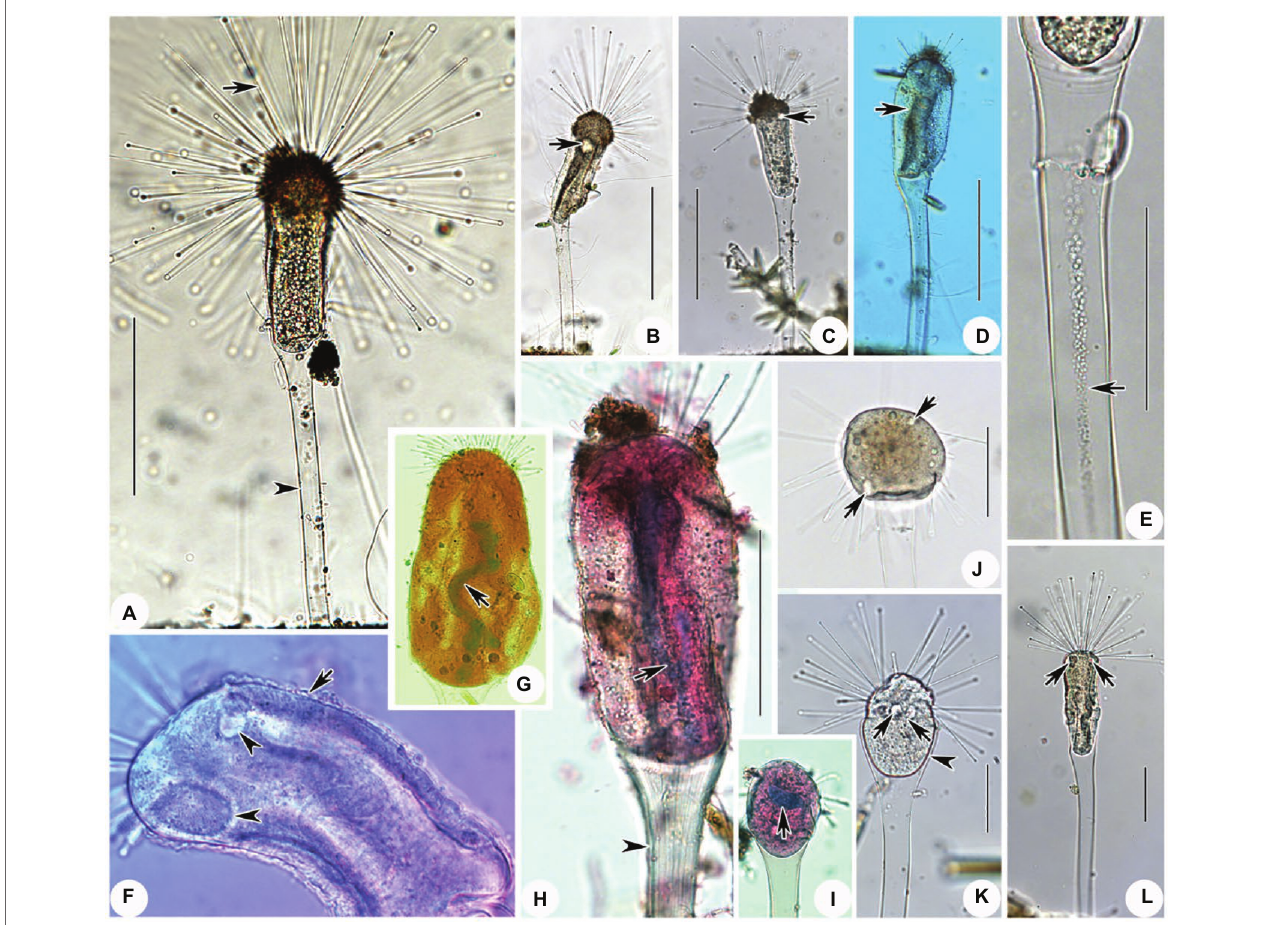
FIGURE 5 | Photomicrographs of Peridiscophrya florea (Kormos & Kormos, 1958) Dovgal, 2002 from life (A–F , J–L) and after Methyl Green-Pyronin Staining (G–I) . (A) Peridiscophrya florea in vivo . Arrow to show tentacle. Arrowhead to show stylotheca. (B–D) Different individuals. Arrows in (B,C) to indicate contractile vacuoles. Arrow in (D) to indicate longitudinal furrows. (E) Same individual as (J–L) enlarged to show the particles (arrow) in stylotheca. (F) Enlarged the ciliate body. Arrow to show lorica with dense rings. Arrowheads to show the contractile vacuoles. (G–I) Peridiscophrya florea after Methyl Green-Pyronin Staining. Arrow in (G) to show the filiform macronucleus. Arrow in (H) indicates ramified macronucleus. Arrowhead to show vertical lines on the stylotheca. Arrow in (I) to show rod-like macronucleus during the growth process. (J–L) The process of lorica growth. Arrows in these pictures to show contractile vacuoles. Arrowhead in (K) to show lorica. Scale bars = 100 μ m (A–D) , = 50 μ m (E , H , J–L)